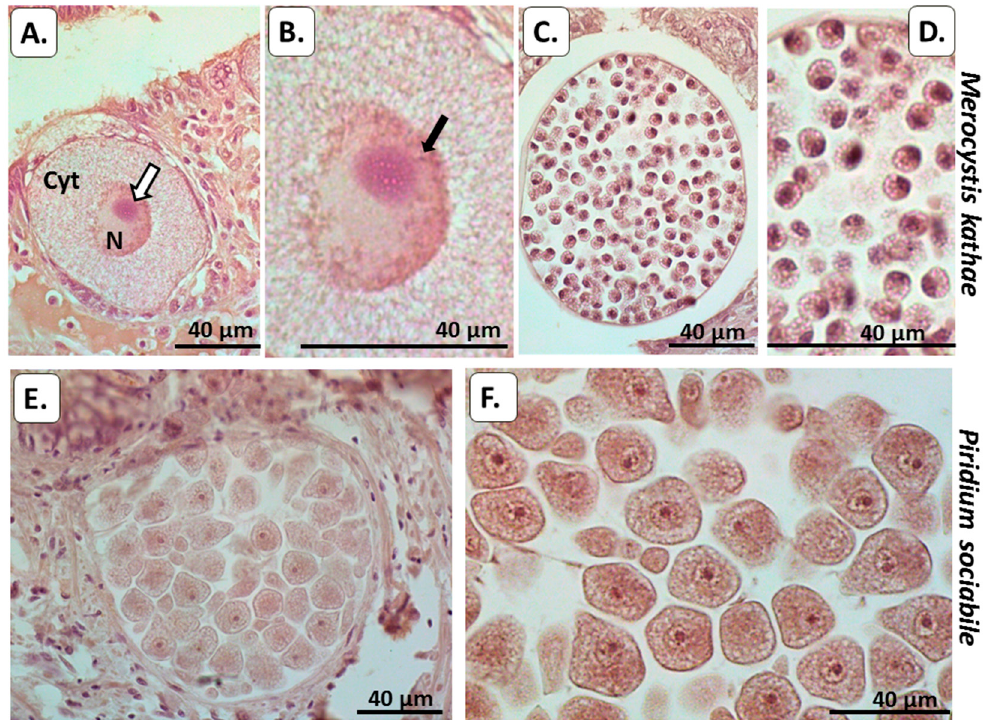
Figure 4. Deiminated proteins detected by pan-citrulline F95 antibody in the two alveolate species. ( A – D ) A whelk kidney infected with Merocystis kathae : ( A ) Mature macrogamont of M. kathae with a prominent nucleus (N) and nucleolus (white arrow). ( B ) Higher magnification of a mature macrogamont showing the positive F95 detection in more details. In addition to the nuclear membrane, the positive F95 reaction seems to extend into the nucleus itself (arrow). ( C ) An immature M. kathae oocyst with numerous sporoblasts. ( D ) Sporoblasts shown at higher magnification, showing positive F95 reaction in the cytoplasm of the sporoblasts. ( E ) Numerous encysted parasite bodies of P. sociabile in the whelk foot. ( F ) Higher magnification, showing several parasite bodies with obvious F95-positive reaction in the cytoplasm, nucleus and nucleolus. The surrounding host tissues (whelk kidney and foot) also show some F95 positive. Scale bar is indicated in each figure and is 40 µm.